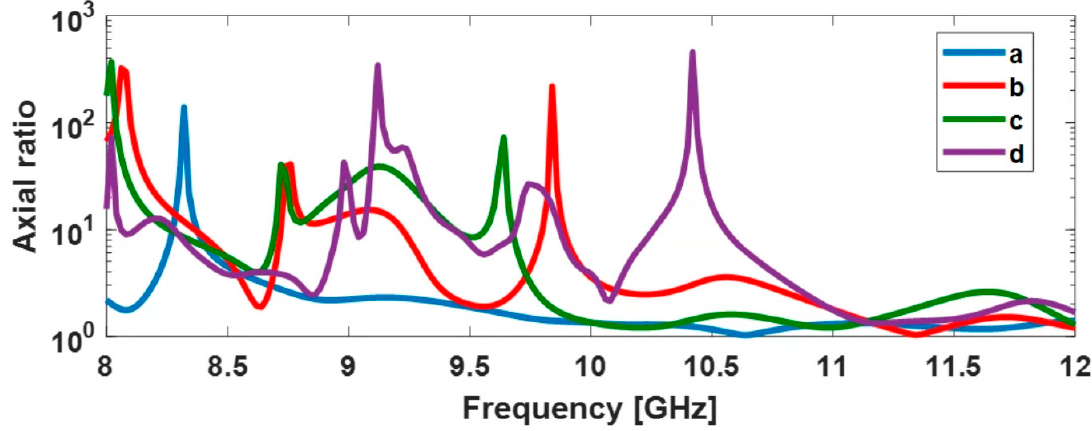
Figure 19 . Simulated axial ratio as a function of frequency for 𝜃 = 0° and 𝛷 = 0° . Table 4. Simulated and measured results for the four radiating systems with multi-layer FSS structures.